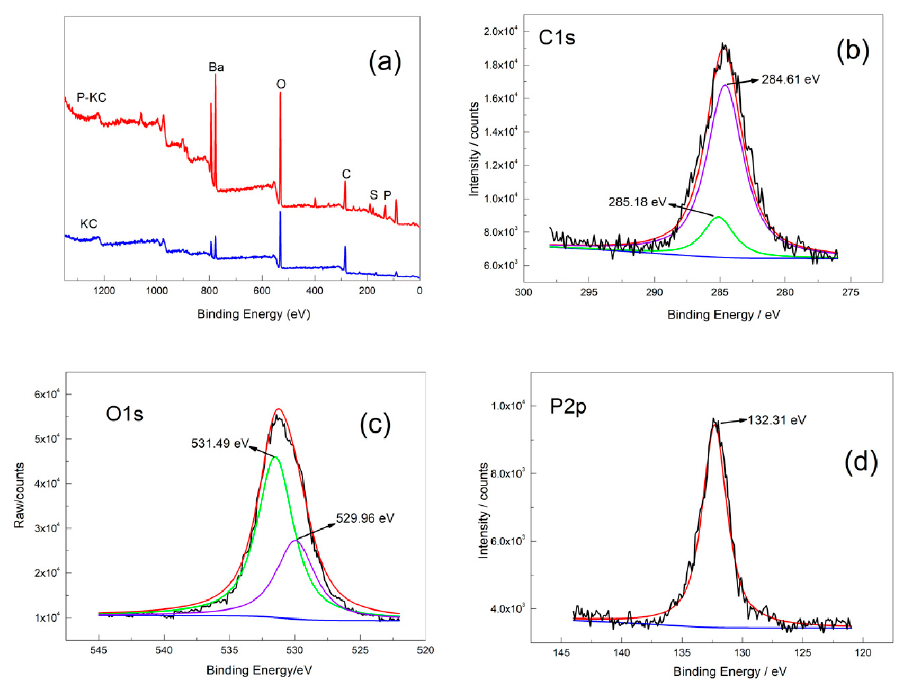
Figure 3. ( a ) X-ray photoelectron spectroscopy (XPS) full spectra of KC and P-KC. ( b ) C1s spectra of P-KC. ( c ) O1s spectra of P-KC. ( d ) P2p spectra of P-KC. Table 2. Electron binding energy and atomic ratio of main elements on P-KC surface. Element Peak Position